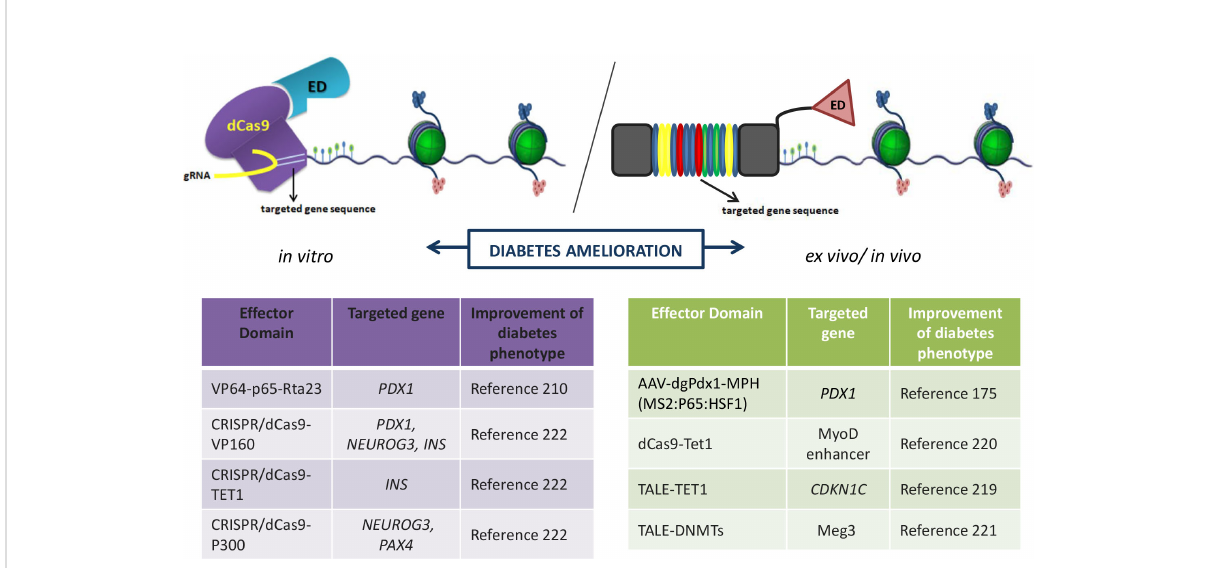
FIGURE 5 Improvement of diabetic conditions by epigenome editing using CRISPR/dCas9 synthetic tools. The epigenome editing is cutting edge research tool for deciphering the pathology of diabetes and for offering a potential cure. The existing epigenetic editing tools are consisting of target DNA sequence recognition part (TALEN or dCas9) and linked to different effector domains (ED). ED could be any of epigenetic modi fi ers of DNA (DNMTs and TETs) or histones (histone modifying enzymes). In regard of diabetes treatment, several in vitro and in vivo studies based on usage of these tools have been recently released and are listed in the inset tables. gRNA-guide